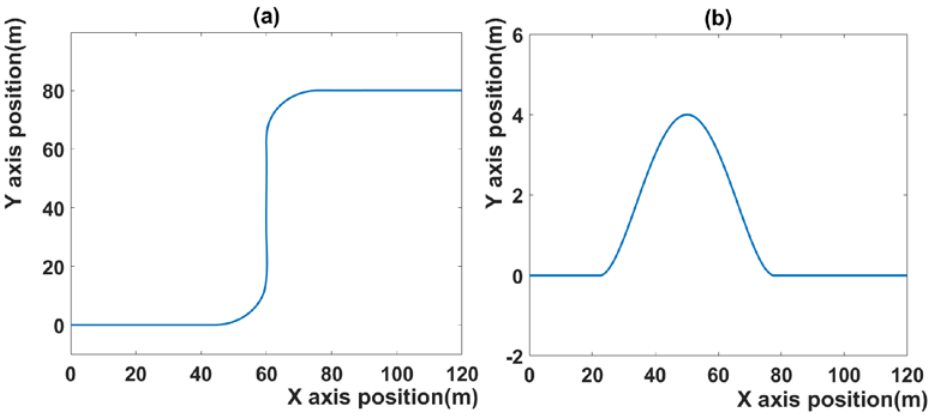
Figure 2. ( a ) Trajectory of scenario 1, ( b ) trajectory of scenario 2.